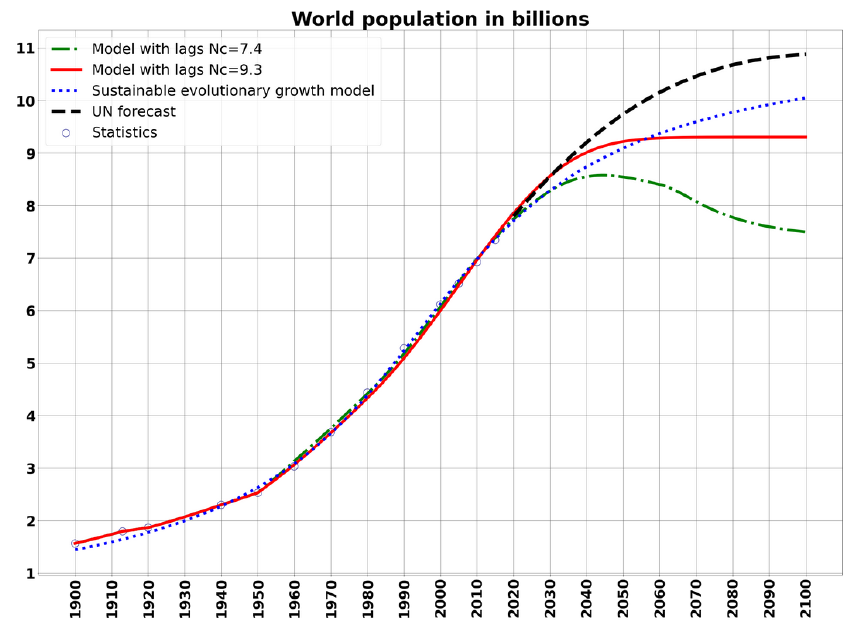
Figure 16. Scenarios of the world’s population in the 21st century.